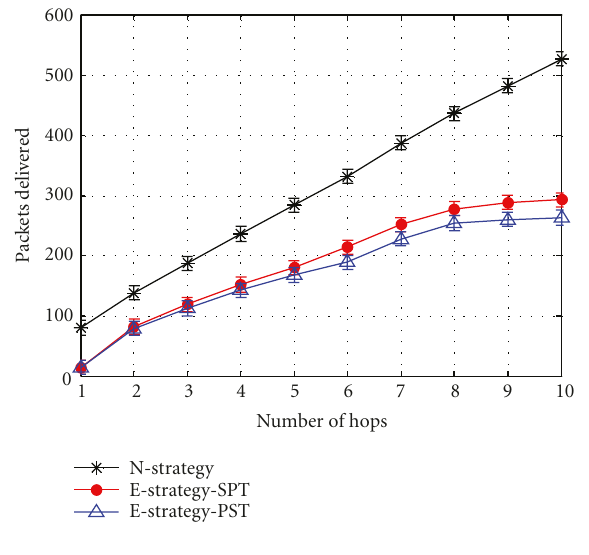
Figure 2: Cost versus query distance.